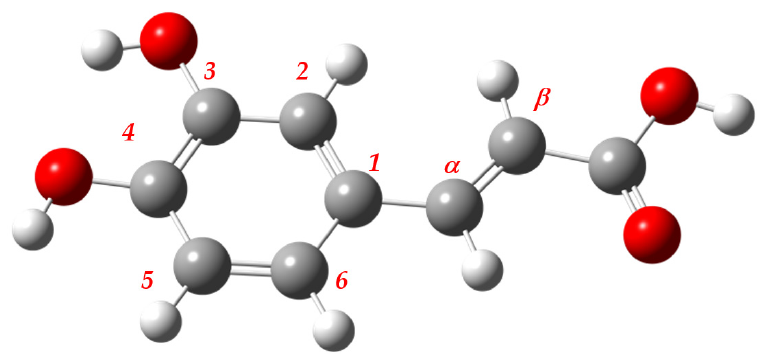
Figure 1. The 3D structure of the reference conformer of caffeic acid.